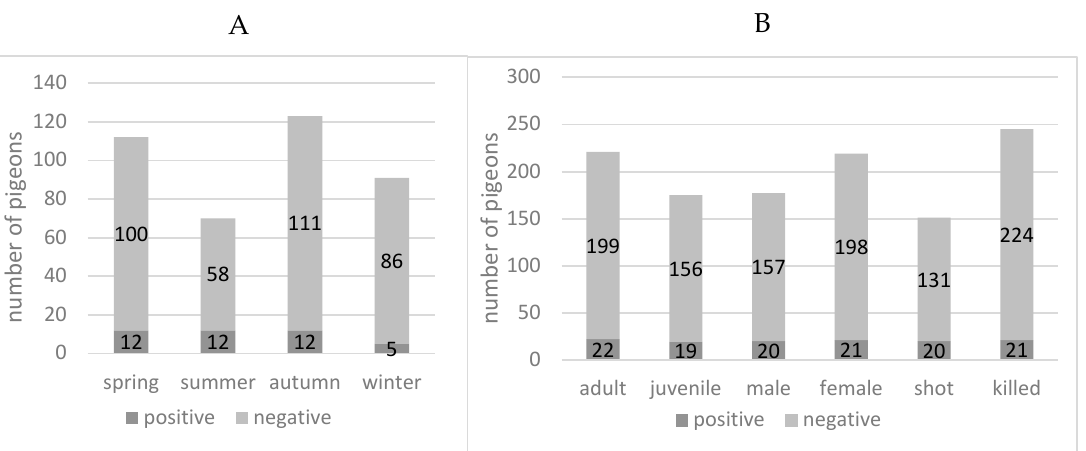
Figure 1. Positivity rate (Avian Orthoavulavirus-1 M-gene rRT-PCR) of feral pigeons ( Columba livia domestica ) from the city of Zurich. ( A ) In different seasons. ( B ) According to age, sex, and mode of death.